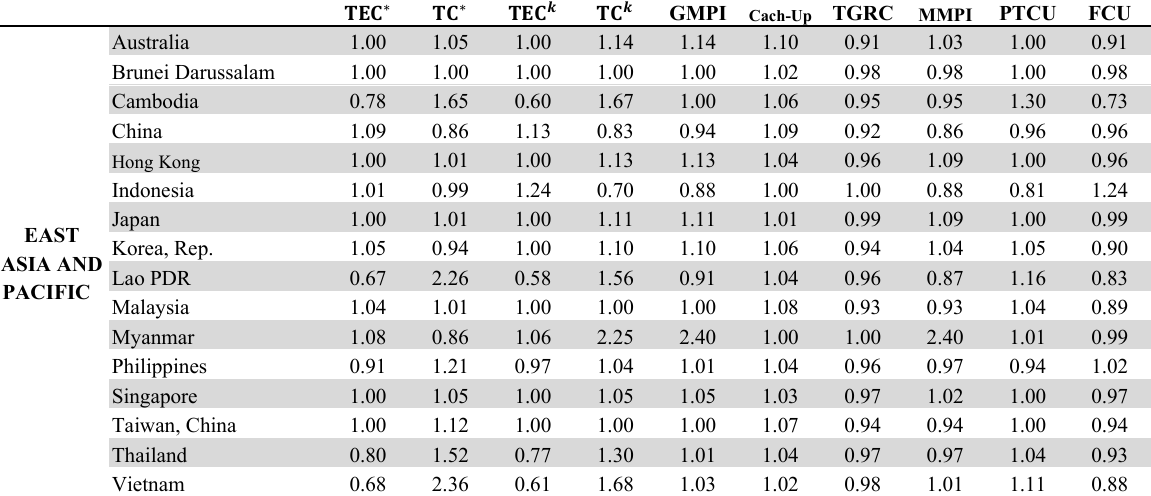
Calculations of Productivity Changes using the metafrontier Malmquist Method for EAST ASIA AND